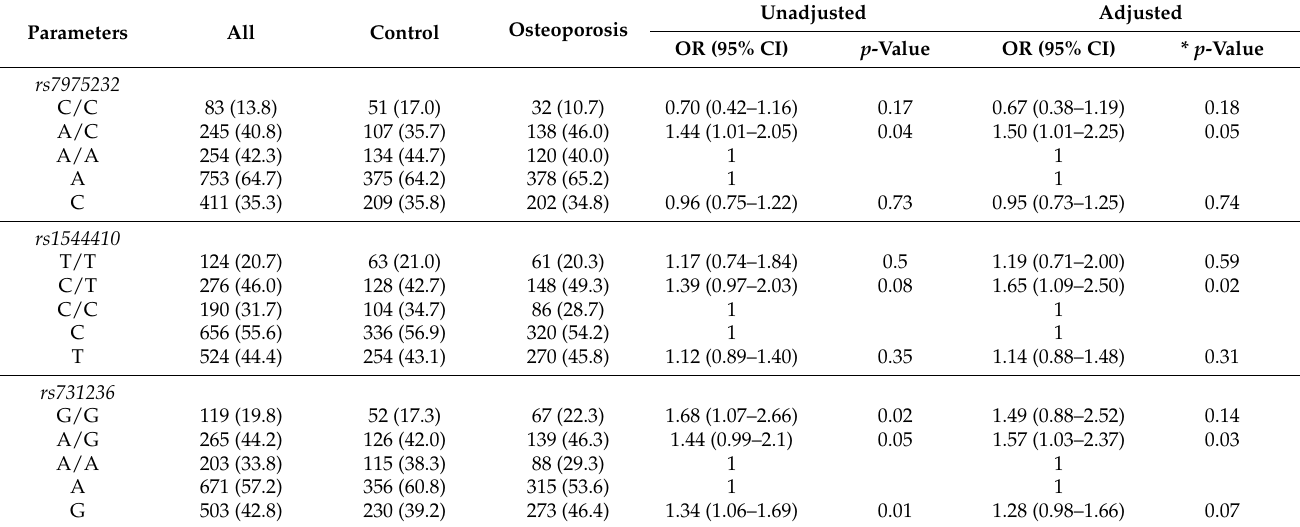
Table 2. Allelic frequency distribution of VDR gene variants.